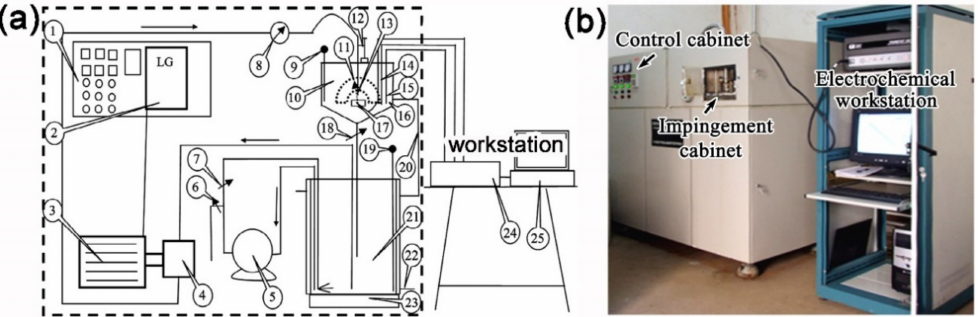
Figure 3. ( a ) Schematic diagram and ( b ) digital picture of the jet impingement apparatus for erosion–